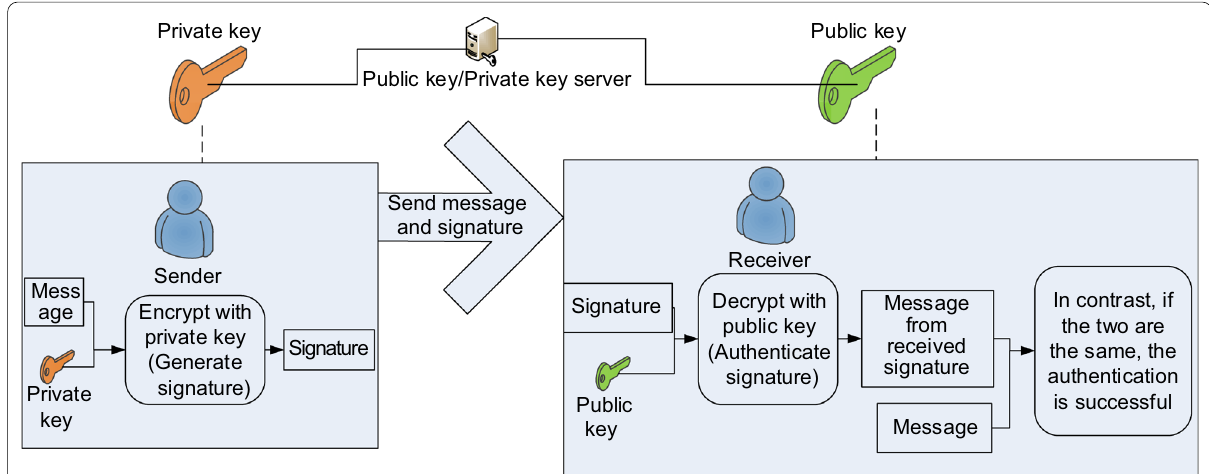
Fig. 1 Schematic diagram of authentication based on digital signature